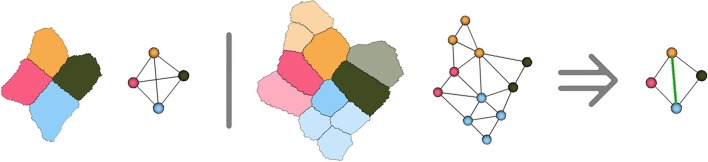
Illustration in two dimensions of the ambiguous junction problem : when more than 4 cells meet, the simplicial complex hypothesis forces to make a choice concerning cell adjacency, that might only be verified by looking at the further evolution of the ambiguous junction.